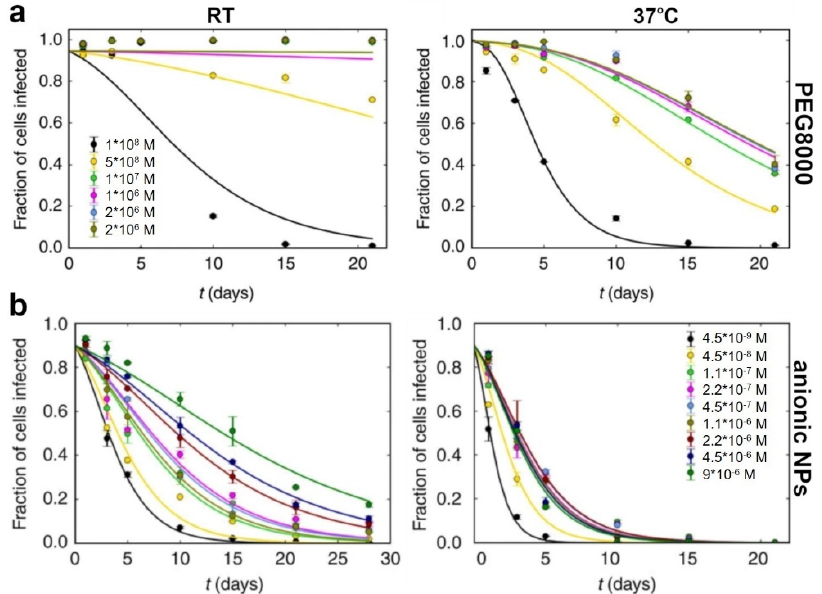
Figure 5. The efficacy of PEG8000 and anionic nanoparticles (NPs) as the thermal ‐ protective addi ‐ tives in adenovirus ‐ based vaccines. ( a )—Fraction of cells infected versus storage time for Ad5 stored in the presence of different concentrations of PEG at RT and at 37 °C, ( b )—Fraction of cells infected versus storage time in days for Ad5 stored in presence of different concentrations of ani ‐ onic MUS:OT NPs at RT and at 37 °C. The panel was adapted from Pelliccia et al. [160], based on the CC BY 4.0